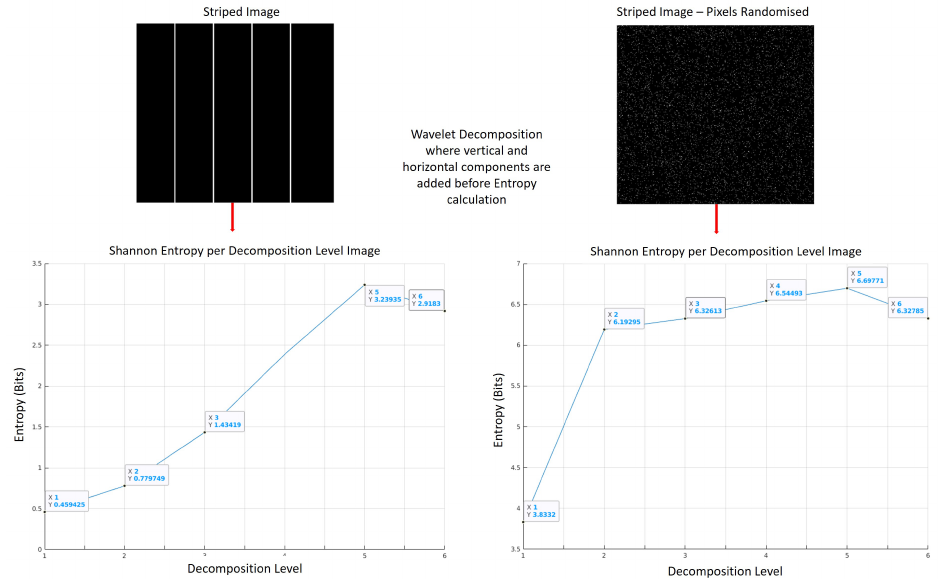
Figure 4. Global structure measurement using Shannon entropy. Both images are 512 × 512 pixels in size.